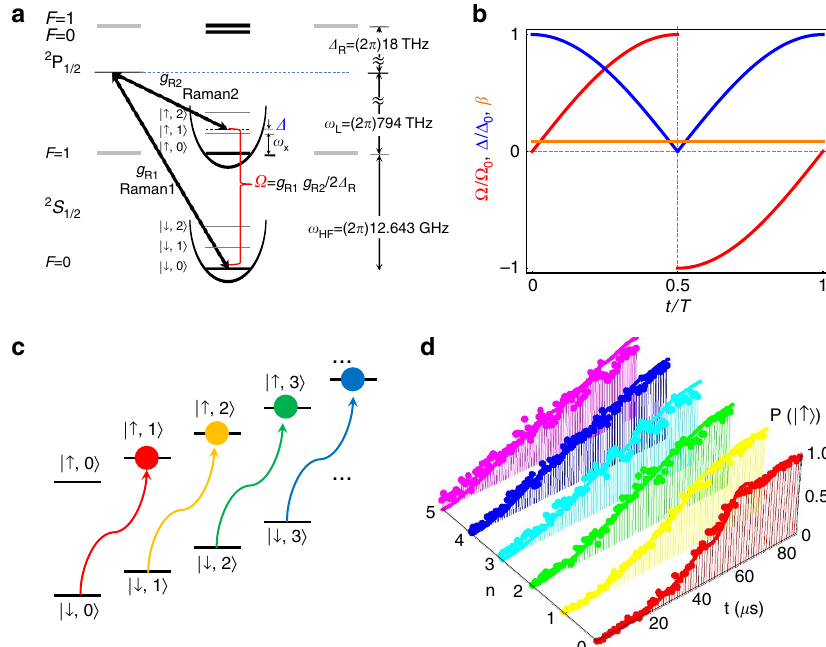
Figure 1 | Experimental scheme and dynamic and adiabatic transition by anti-Jaynes–Cummings interaction. ( a ) 171 Yb þ system in a harmonic potential. The qubit level in S 1/2 manifold, F ¼ 0 ; m F ¼ 0 j i (cid:3) #j i and F ¼ 1 ; m F ¼ 0 j i (cid:3) "j i are coupled by the Raman laser beams, where the beat-note frequency is near resonant to the qubit levels, o HF . When the beat-note frequency is tuned to B o HF þ o X , the scheme produces the anti-Jaynes–Cummings interaction or blue-sideband transition. We denote O as the Rabi frequency on the qubit transition and D is the frequency difference between the beat-note frequency of Raman beams and o HF þ o X . The Raman beams are realized by picosecond pulse train similar to the scheme in ref. 45. ( b ) The controls of experimental parameters of O and D for the uniform blue-sideband transition. Naturally, the Rabi frequency of the blue-sideband transition is dependent on the